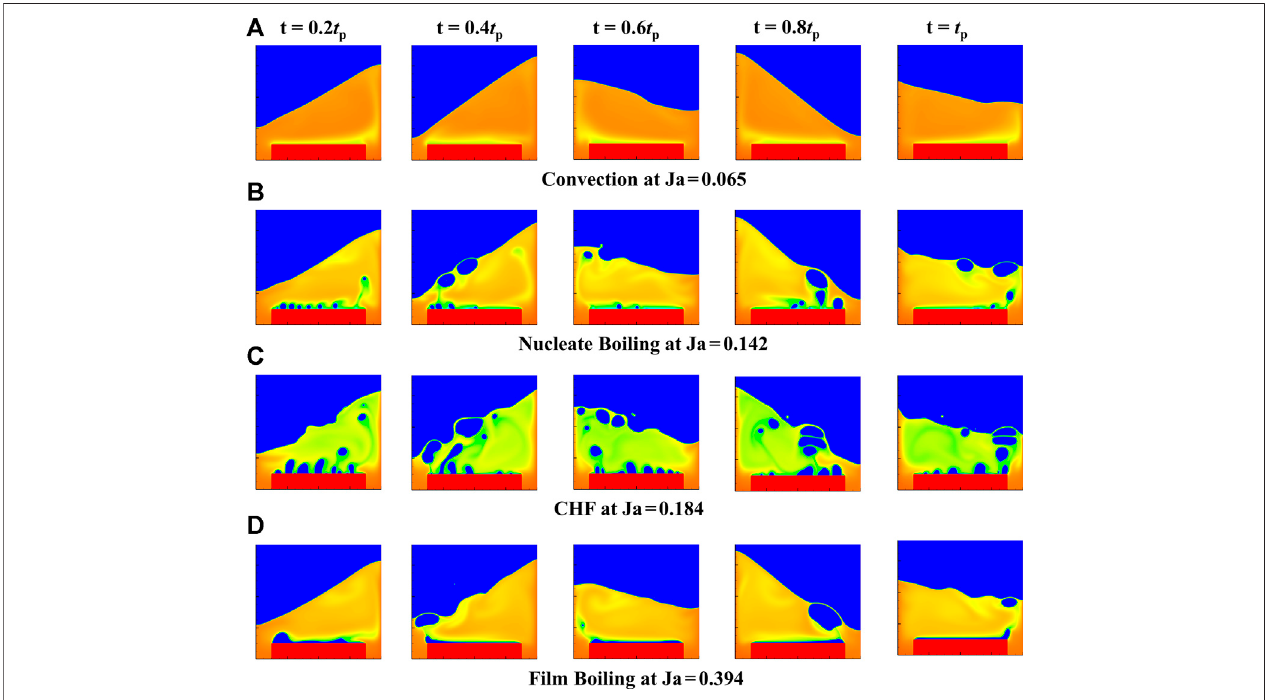
FIGURE 2 | Various regions of pool boiling during one period under rolling condition.